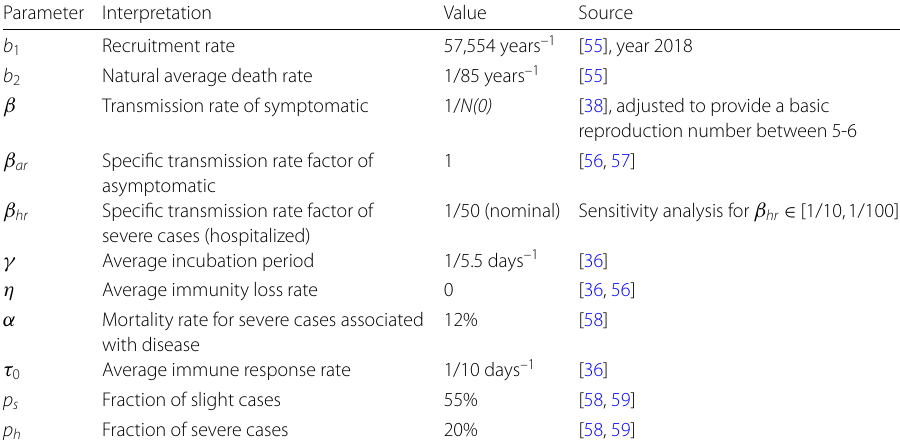
Table 1 Parameter values employed in simulations